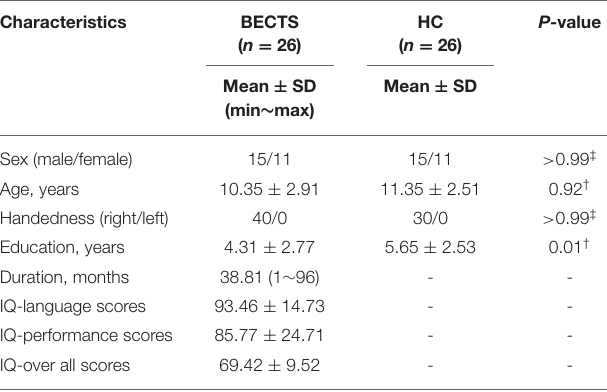
TABLE 1 | Demographic and clinical characteristics of